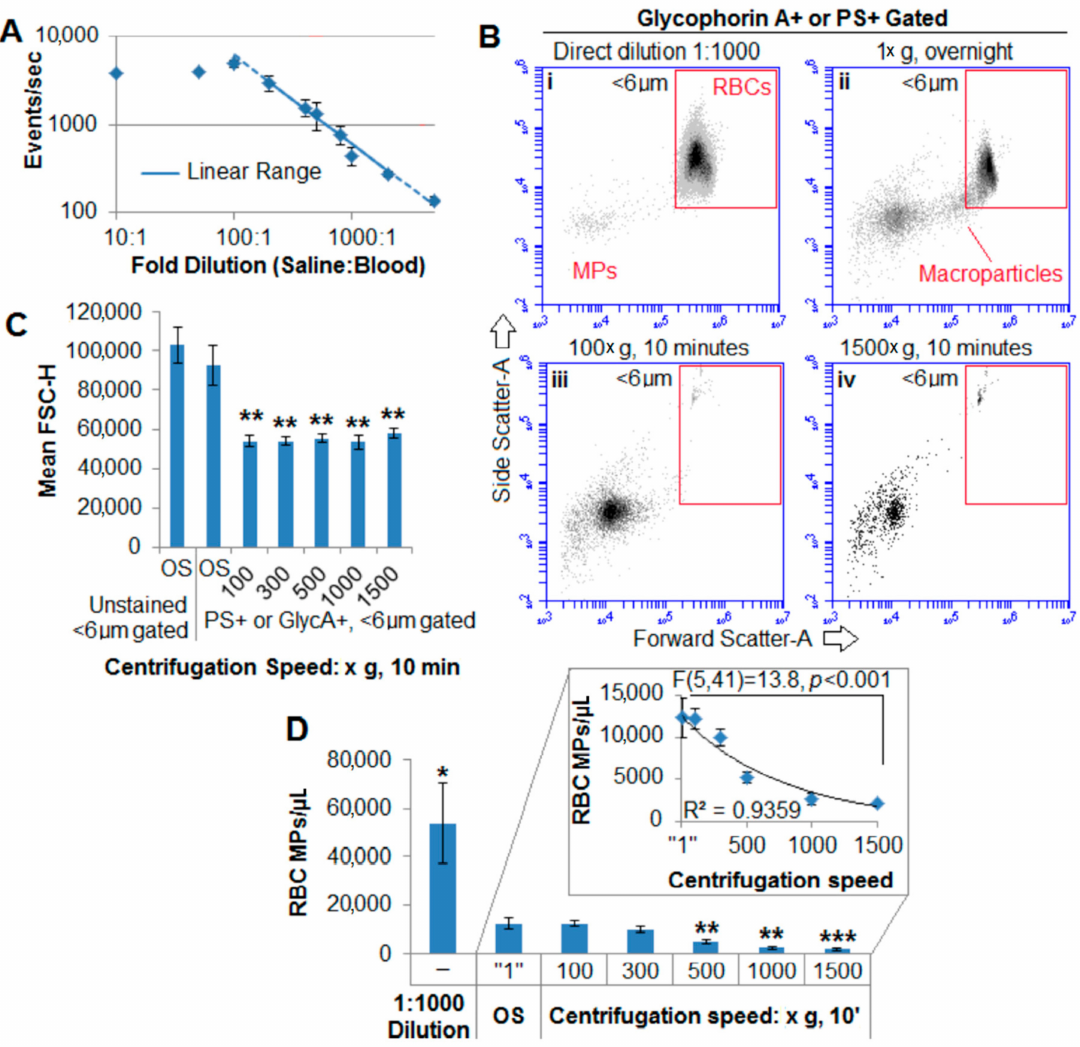
Figure 3. Large vesicles were removed by centrifugation: To examine the effects of centrifugation on the macroparticle population, direct dilution was carried out. ( A ) The linear range of the cytometer was first established by minimizing the variance of a linear fit of the dilution to event rate; n = 3 donor units to identify the midpoint of the linear range. ( B ) Representative light scatter of PS+ or glycophorin A+ events comparing the resulting detected vesicle population. (i) With direct dilution, the RBC population overwhelmed the detection of vesicles (ii) seen with overnight sedimentation. (iii) Even centrifugation at 100 × g for 10 min removed most large vesicles, and (iv) centrifugation at 1500 × g for 10 min resulted in removal of over 85% of vesicles compared to overnight sedimentation. ( C ) There was a significant decrease in the forward scatter height of vesicles (<6 µ m) at 100 × g or more, showing how the macroparticles are removed with low-speed centrifugation. ( D ) Compared to supernatant obtained from overnight sedimentation, there were 4.3-fold more vesicles in blood examined with the same settings used for the other supernatants. There was no significant difference in the total concentration of RBC vesicles at low speed (100 or 300 × g ), but there was a speed-dependent decrease in vesicles relative to supernatant from overnight sedimentation (inset); n = 8–11 (dilutions only had 8 units, whereas the different sedimentation/centrifugation numbers were performed on all 11). “1 × g ”/OS, overnight sedimentation; * p < 0.05; ** denotes t -test p -val. <0.001, and *** <0.0001 relative to “1 × g